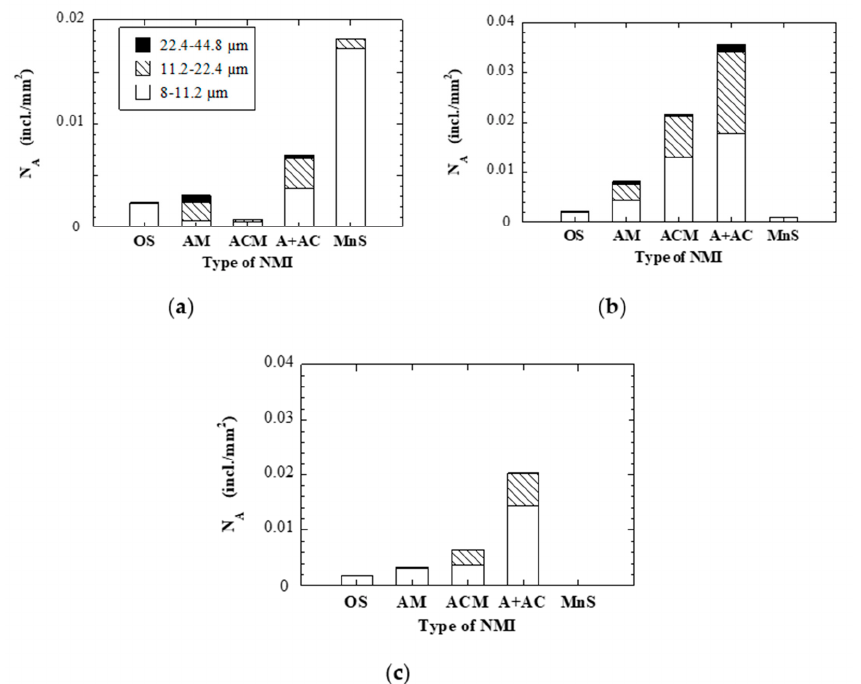
Figure 3. Number of di ff erent non-metallic inclusions (NMIs) per unit area (N A ) observed by two-dimensional (2-D) investigations on di ff erent polished steel samples: ( a ) CE-300 M ( b ) ESR-400, and ( c ) PESR-500.